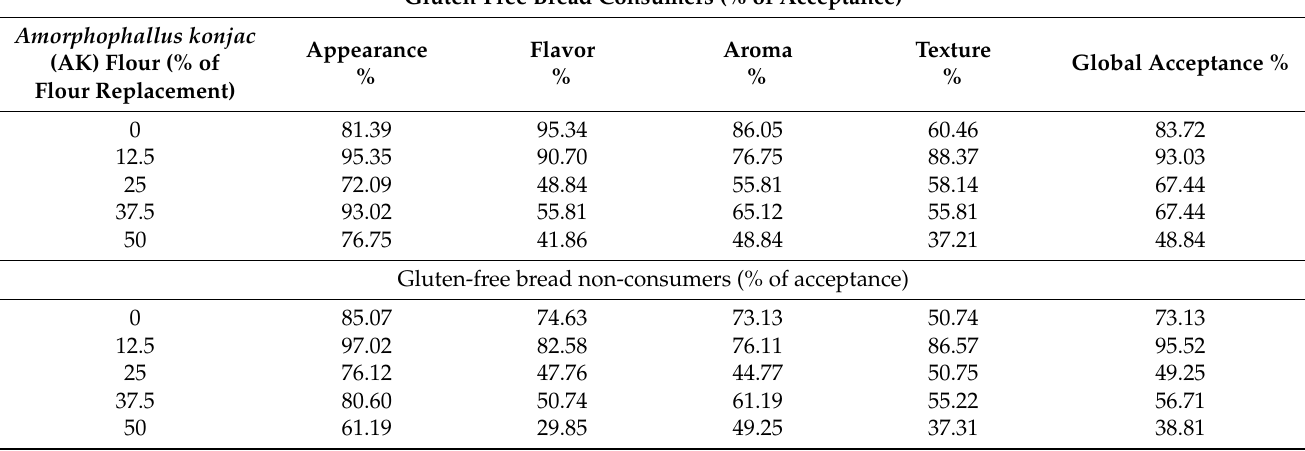
Table 2. Percentage of acceptance of gluten-free bread formulations among consumers ( n = 43) and non-consumers of gluten-free bread ( n =